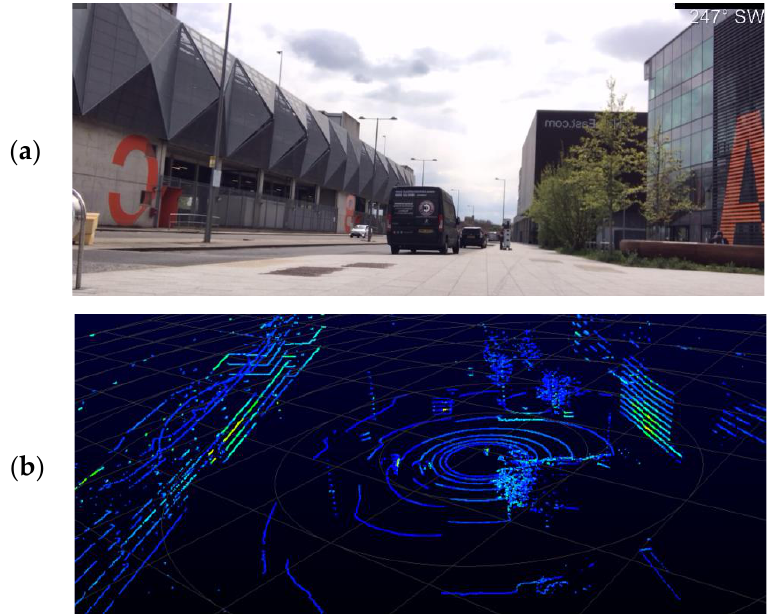
Figure 2. Sample of camera ( a ) and LiDAR ( b ) data from LboroAV2 dataset.